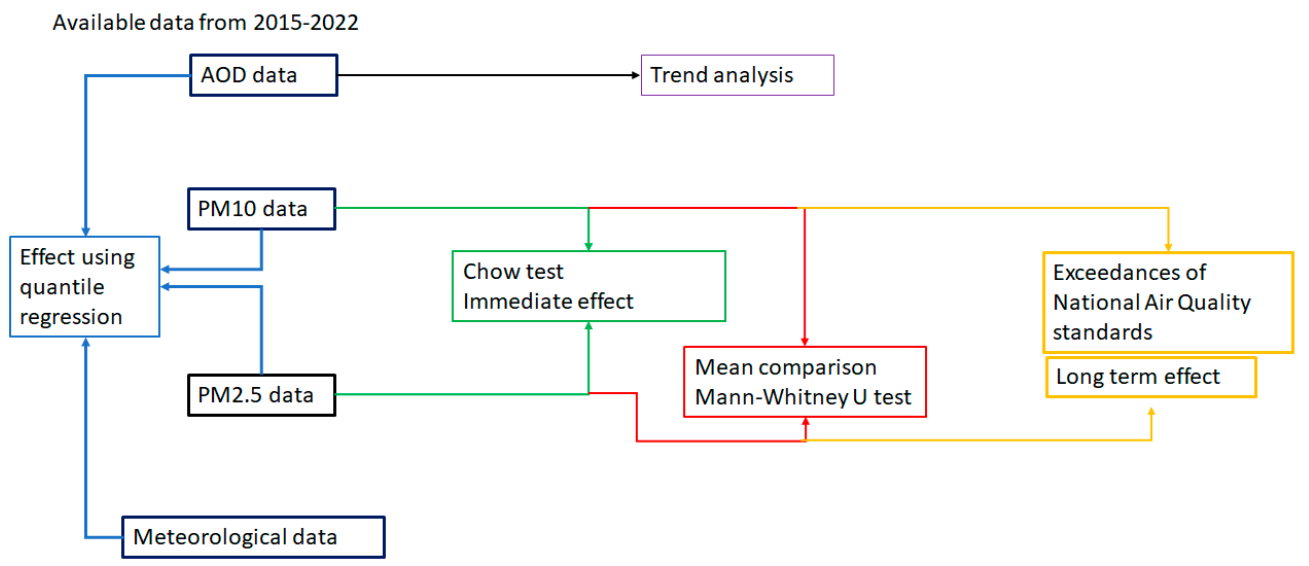
Figure 2. Flow diagram of the methodology of this study.